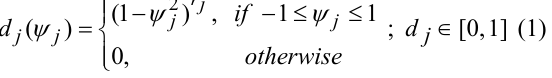
Figure 1. Graphical representation of desirability function: a) NTB, b) LTB, c)